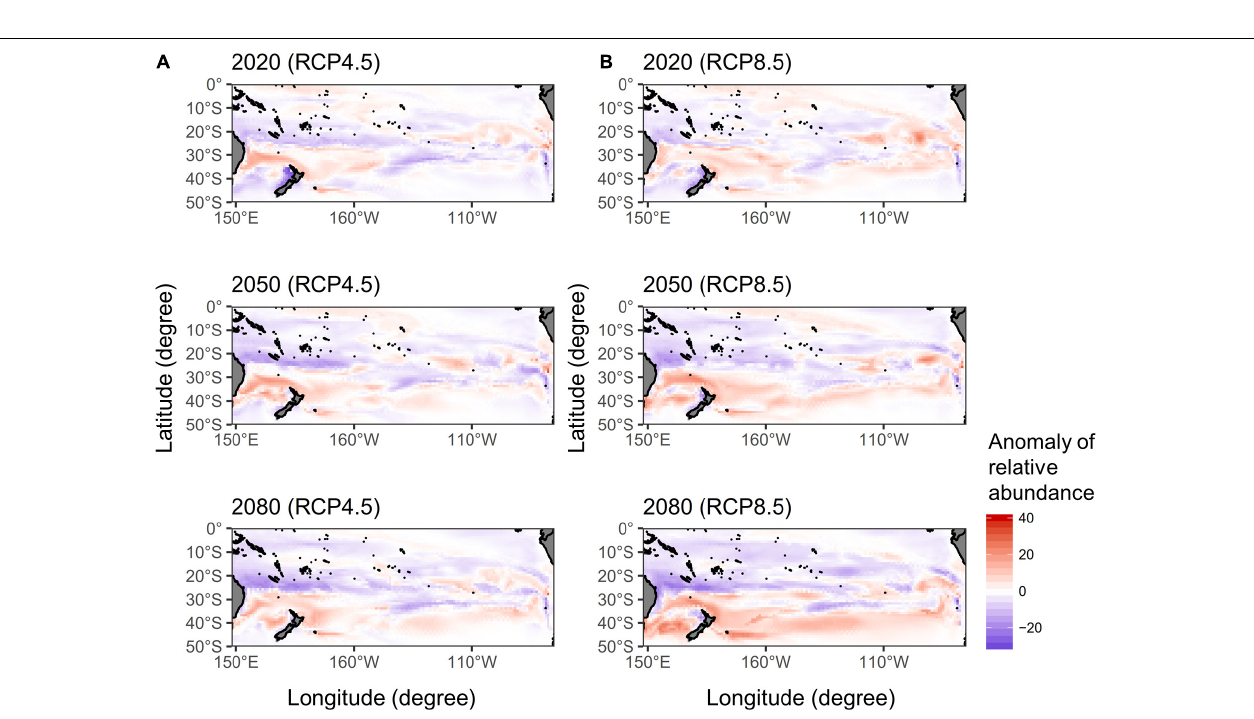
FIGURE 4 | The spatial distributions of the anomaly of relative abundance for south Pacific albacore in quarter 3 calculated by subtracting the predictions of the median ensemble GAM projections in 2020, 2050, and 2080 from the recent average of 2012–2016 under the (A) RCP 4.5 and (B) RCP 8.5 scenarios.